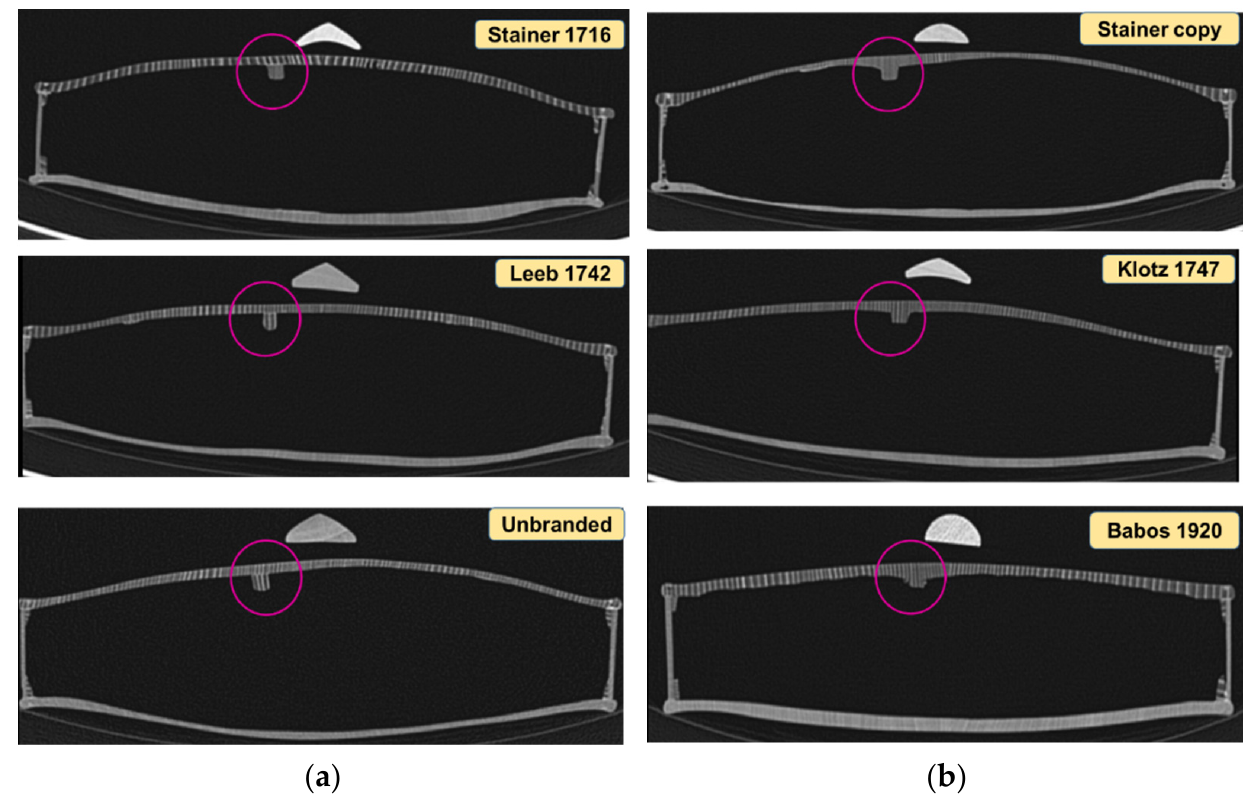
Figure 11. Cross section through CT-scanned violins: ( a ) violins with the applied resonance bar; ( b ) violins with the resonant bar processed from the top plate thickness.